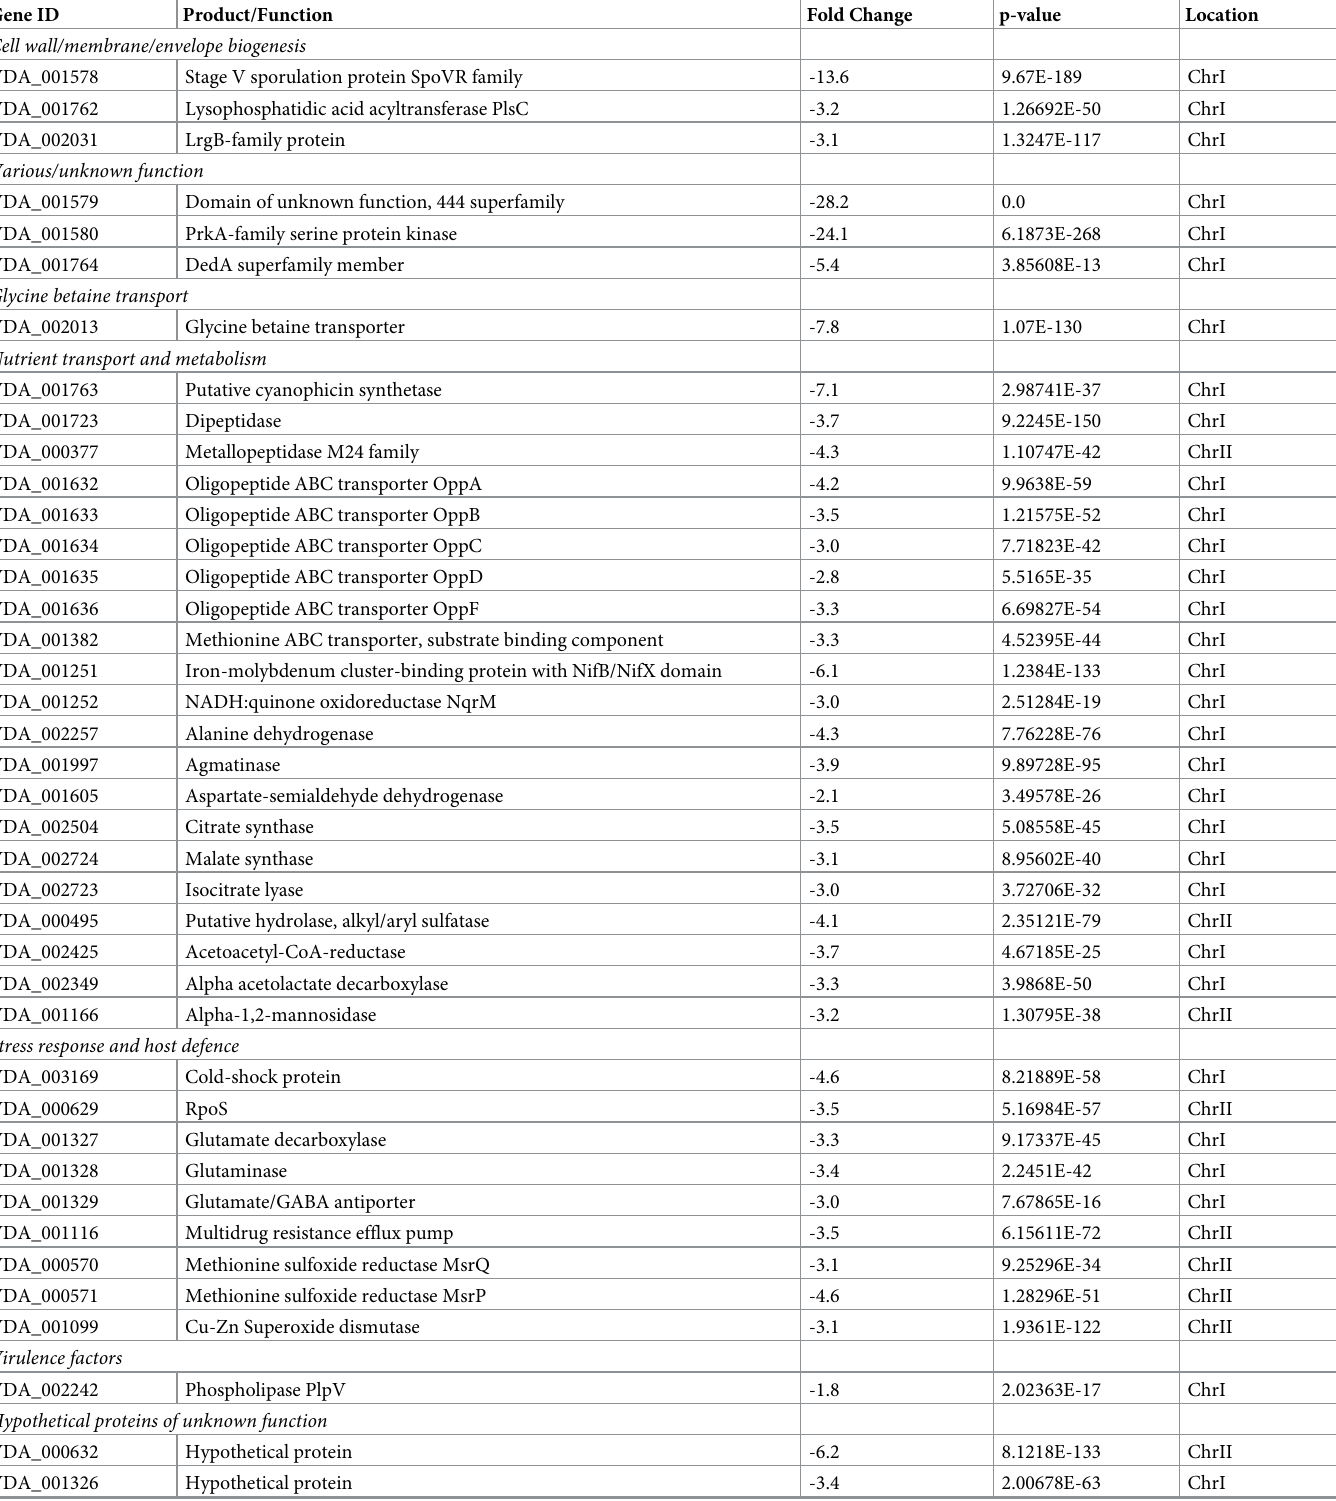
Table 2. List of the top DEGs in Pdd with lower expression at 25˚C than at 15˚C. Note that downregulated expression at 25˚C is denoted by negative FC values. Gene